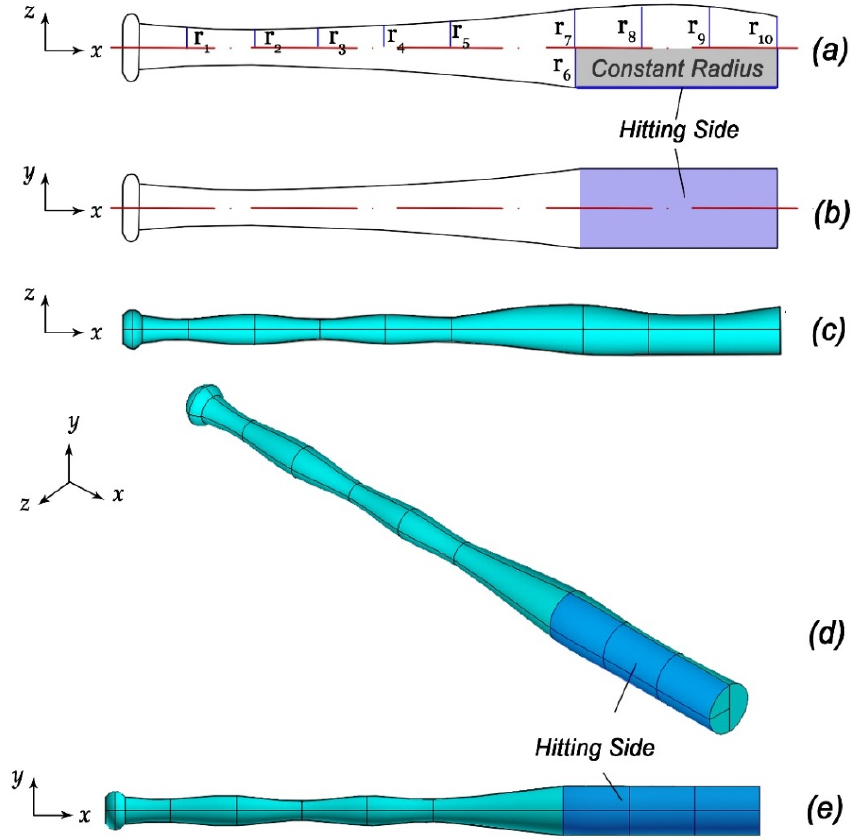
Figure 3. ( a ) Parametric design of the baseball bat (top view). ( b ) Parametric design of the baseball Figure 3. (a) Parametric design of the baseball bat (top view). (b) Parametric design of the baseball bat (front view). ( c ) A randomly generated bat design (top view). ( d ) A randomly generated bat bat (front view). (c) A randomly generated bat design (top view). (d) A randomly generated bat design (isometric view). ( e ) A randomly generated bat design (front view). design (isometric view). (e) A randomly generated bat design (front view). Table 1. Mechanical properties of sugar maple ( Acer saccharum Marshall) and white ash ( Fraxinus americana L.) [36]. Density (kg/m 3 ) Wood Maple